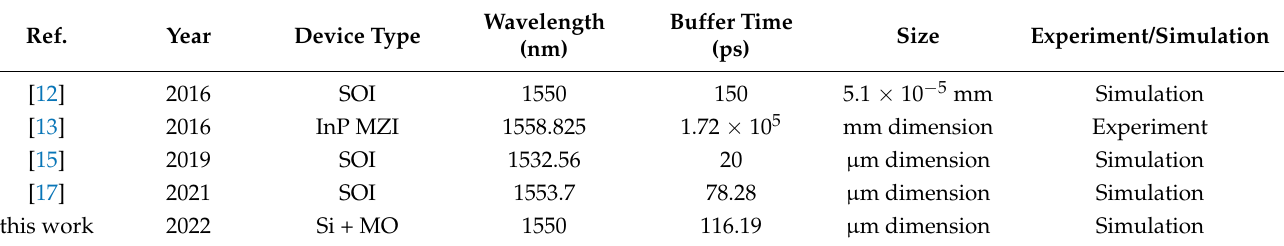
Table 1. Comparison of characteristics of MR structure optical buffers.